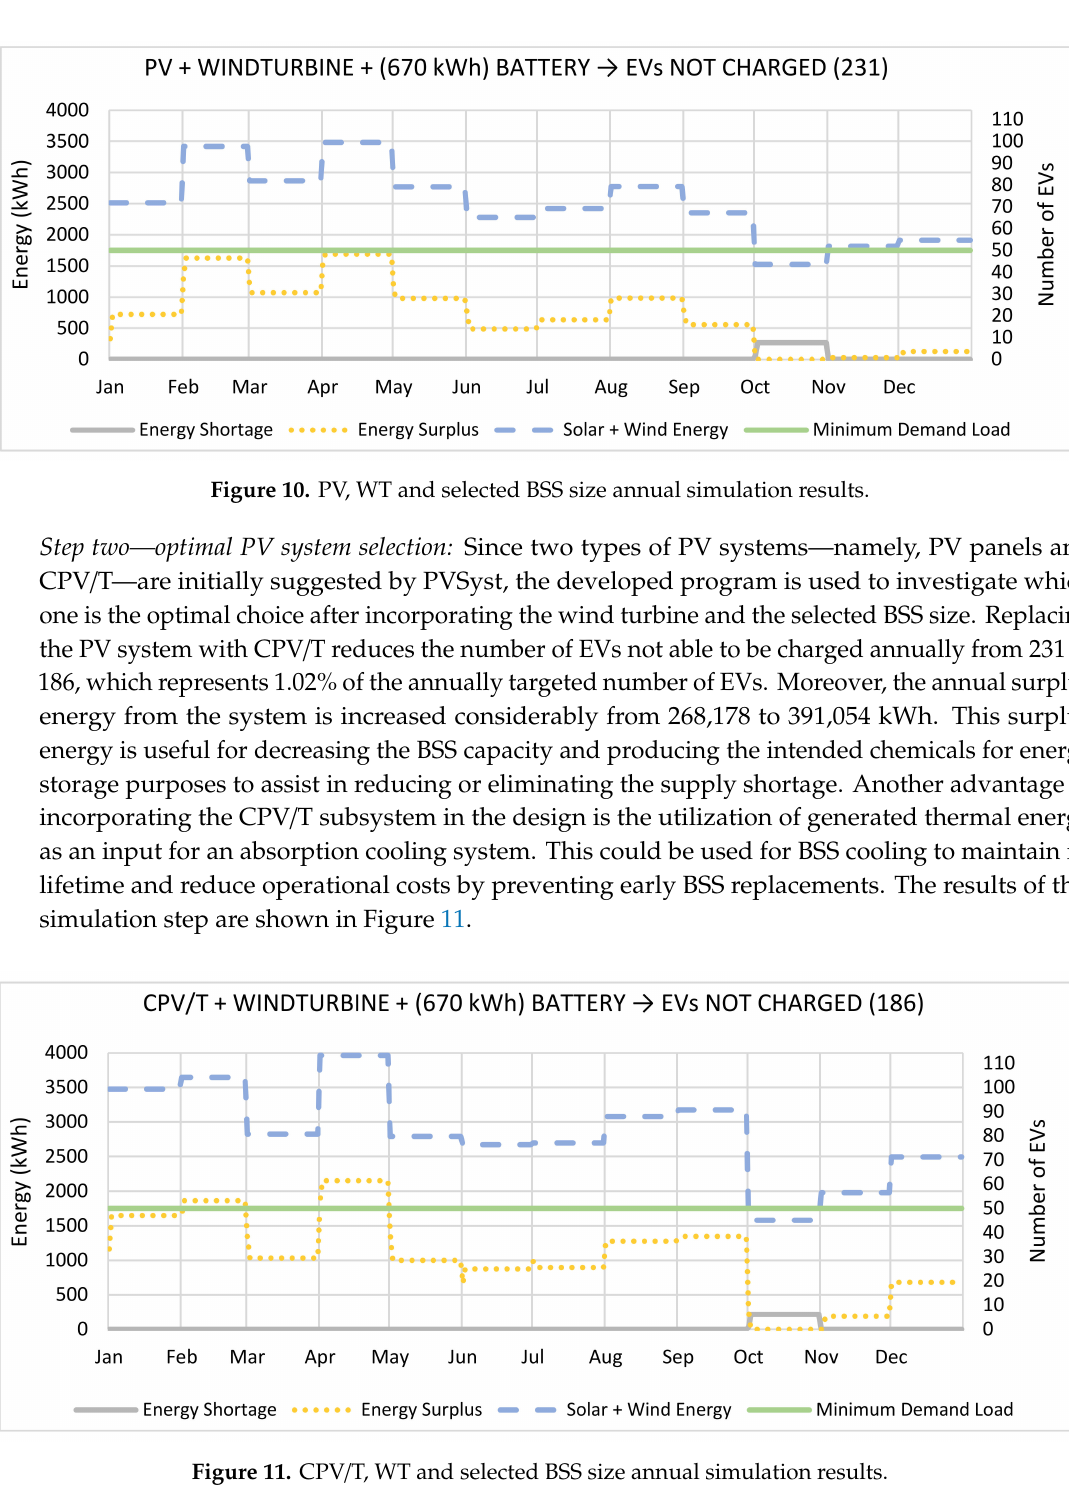
Figure 11. CPV / T, WT and selected BSS size annual simulation